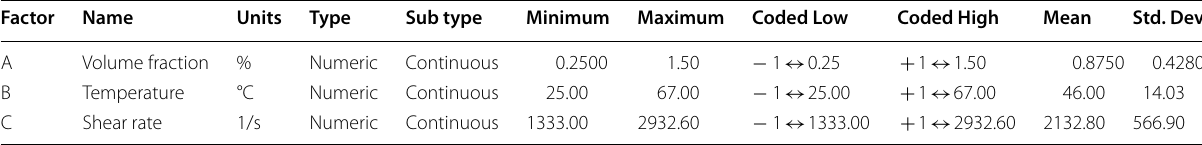
Table 7 Input variables of RSM